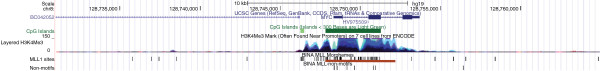
Zoom-out view of morpheme occurrences in MYC locus. Horizontal green bars mark the position of CGIs. Horizontal brown bars mark the chromatin segment bookmarked by MLL1 during mitosis [31]. Track labeled “MLL1 sites” marks the position of MLL1 morphemes; “non-motifs” mark the position of sequences not found in results of SELEX assays [24]. Track labeled “Layered H3K4me3” shows the position of H3K4me3 marks [59].